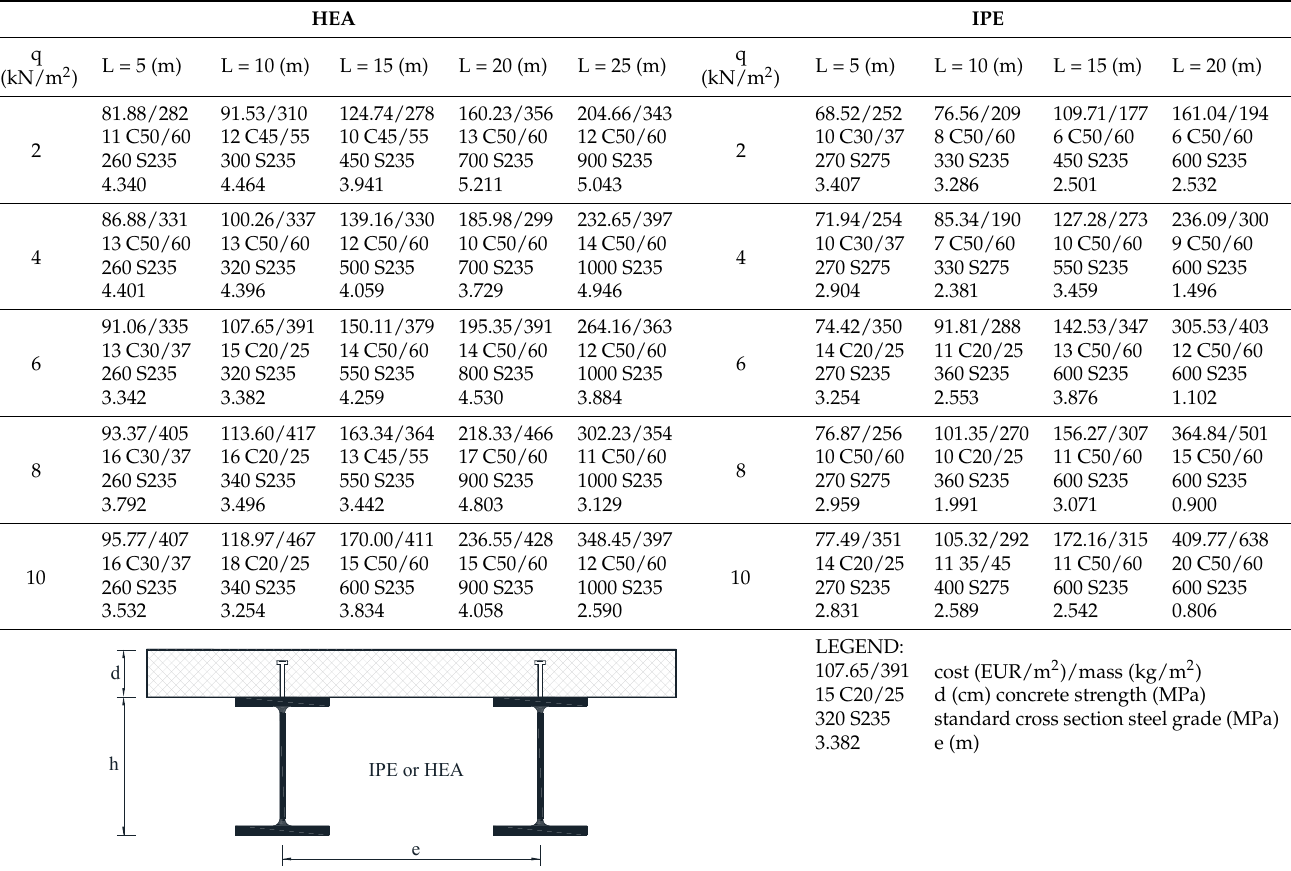
Table 6. Recommended optimal design for the CFS system with standard steel sections (ELCC